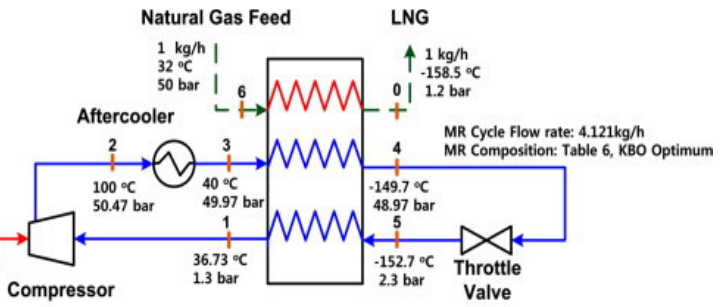
Figure 28. SMR natural gas liquefaction process [96]. Reproduced with permission from Elsevier (license number 5413460250916).